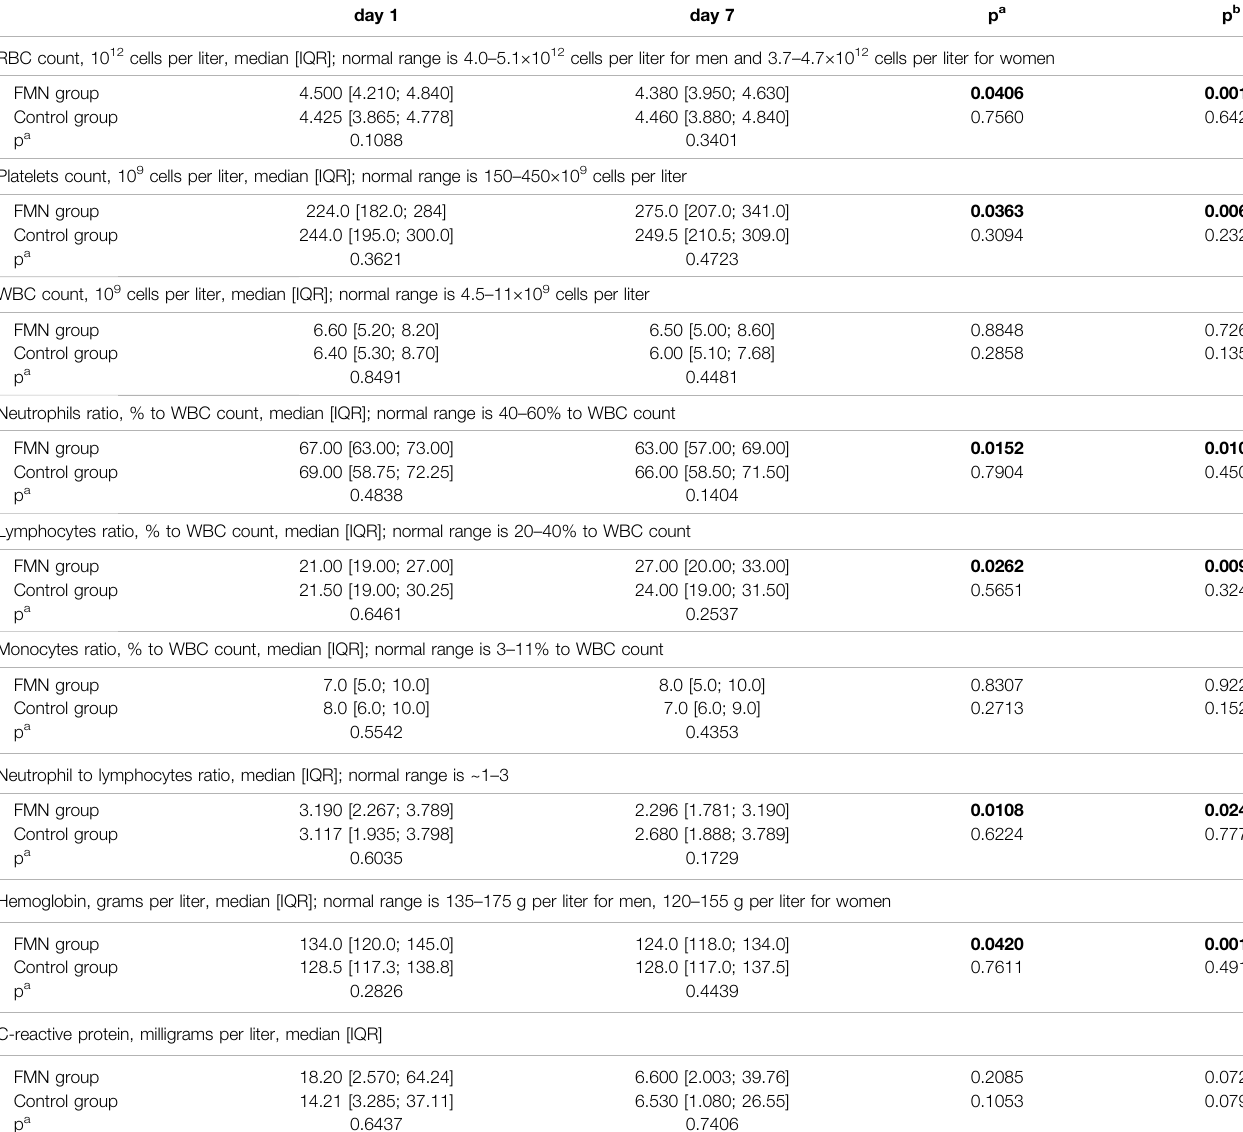
TABLE 3 | Dynamics of main blood and biochemical parameters within 1 week after admission to the hospital in FMN group ( n = 50) and control group ( n = 69). day 1 day 7 p